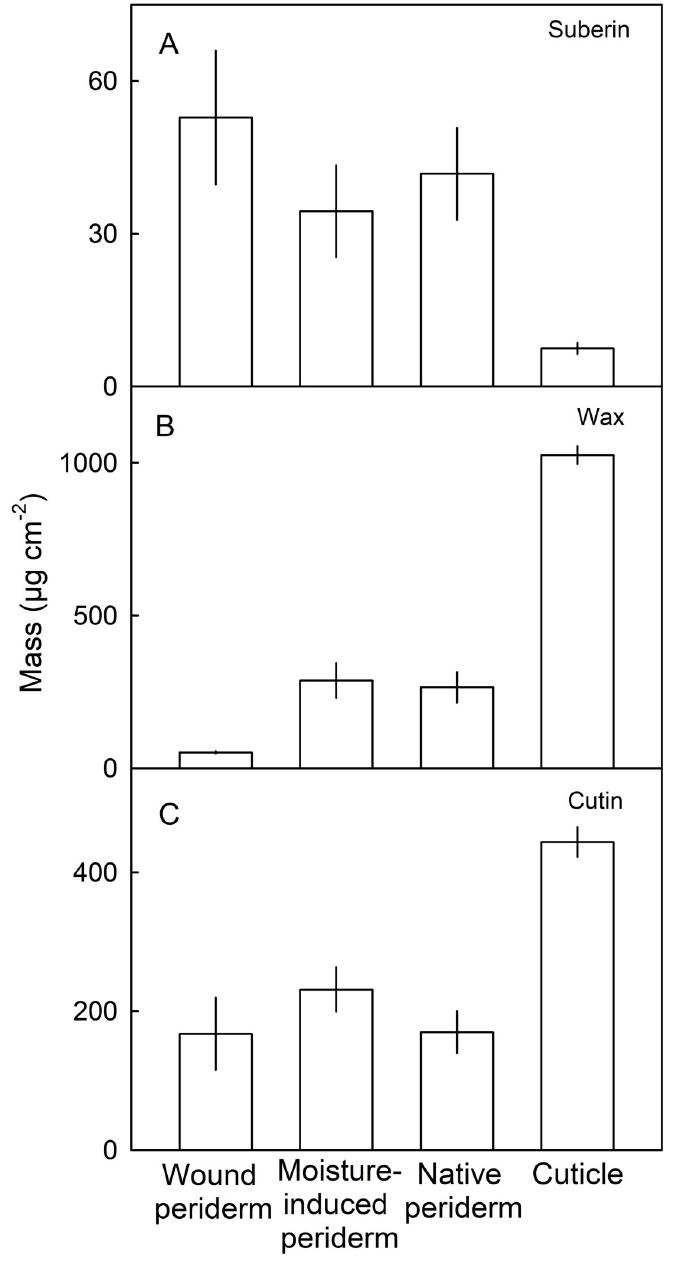
Fig 8. Total masses of suberin (A), wax (B) and cutin (C) in patches of skin of mature apple fruit. Periderm formation in the fruit skin was induced during early fruit development by abrading the cuticle using fine sandpaper (‘Wound periderm’) or by exposing the fruit skin to surface moisture for 12 d between 31 and 43 days after full bloom (DAFB; ‘Moisture-induced periderm’; [22]). The treated patches of skin were excised at maturity 156 DAFB. Periderm from naturally russeted fruit (Native periderm) and cuticles from non-treated, non-russeted fruit (Cuticle) served as controls. Data represent means ± SE of two to three replicates comprising periderms and cuticles of five fruit each.